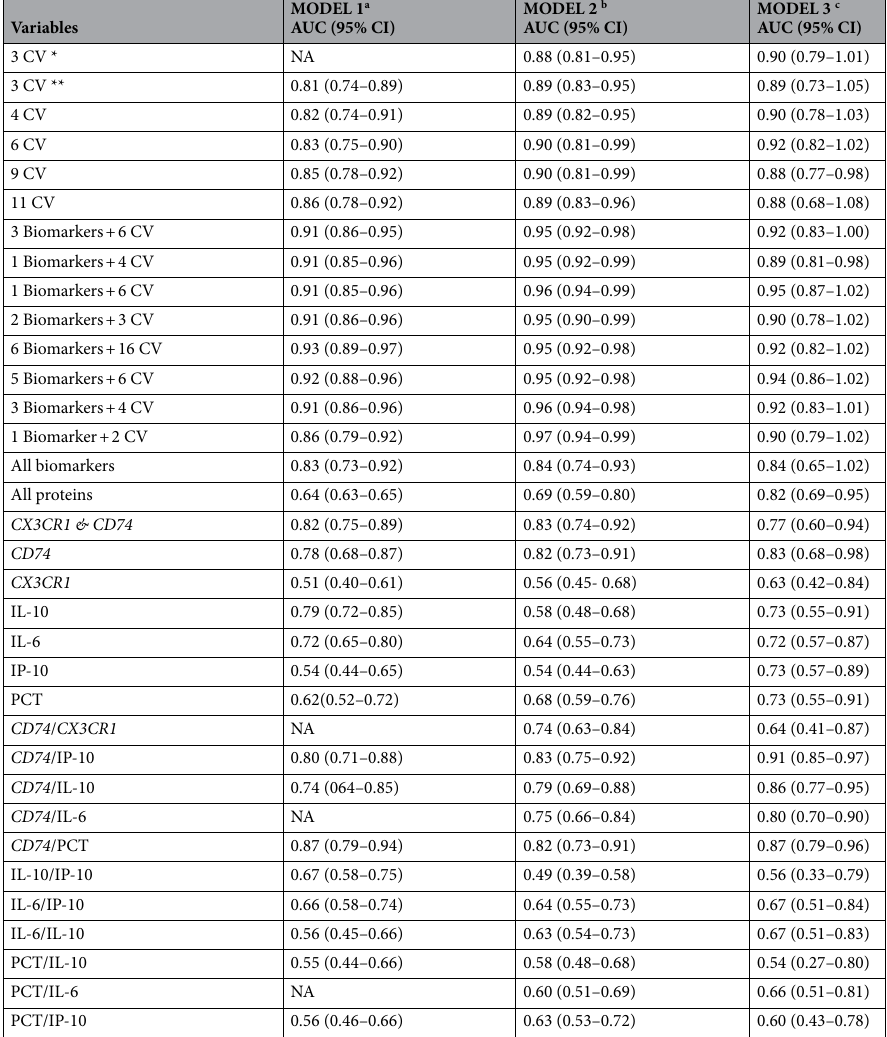
Table 6. Area under the receiver operating curve for the prognosis of neonatal clinical sepsis. a Hospital